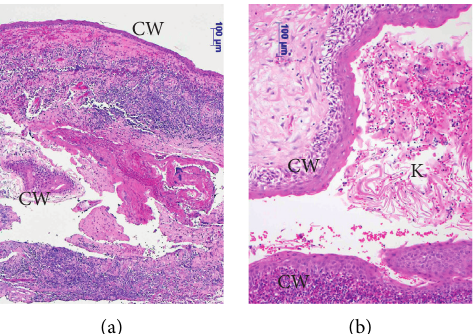
Figure 3: Histopathological examination shows features of the dermoid cyst. The lining is typically a squamous epithelium adjacent to glial tissues with inflammation (a). The cyst lumen contains keratin (b). CW: cyst wall and K: keratin.